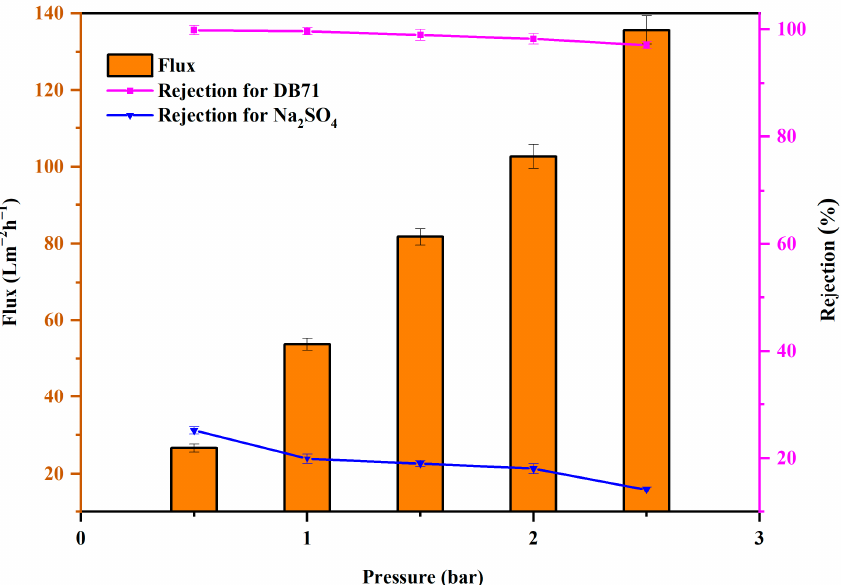
Figure 13. Water flux and rejection of PES–DPS–1 at different pressures (dye: 0.2 g · L − 1 ; salt: 2 g · L − 1 ).